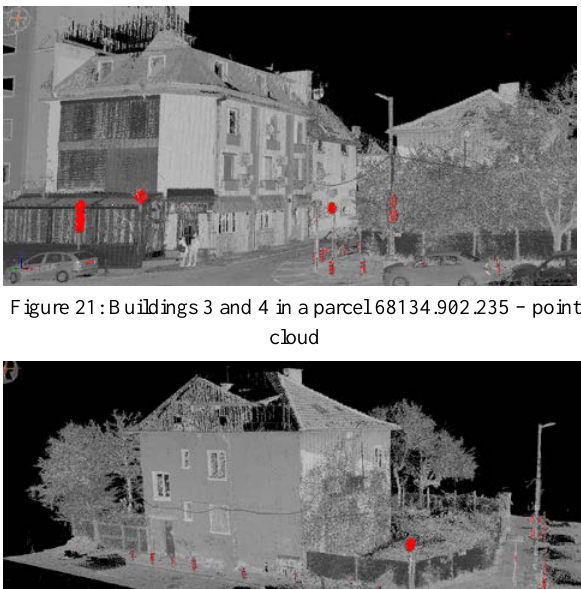
Figure 20: Building in a parcel 68134.902.236 – point cloud